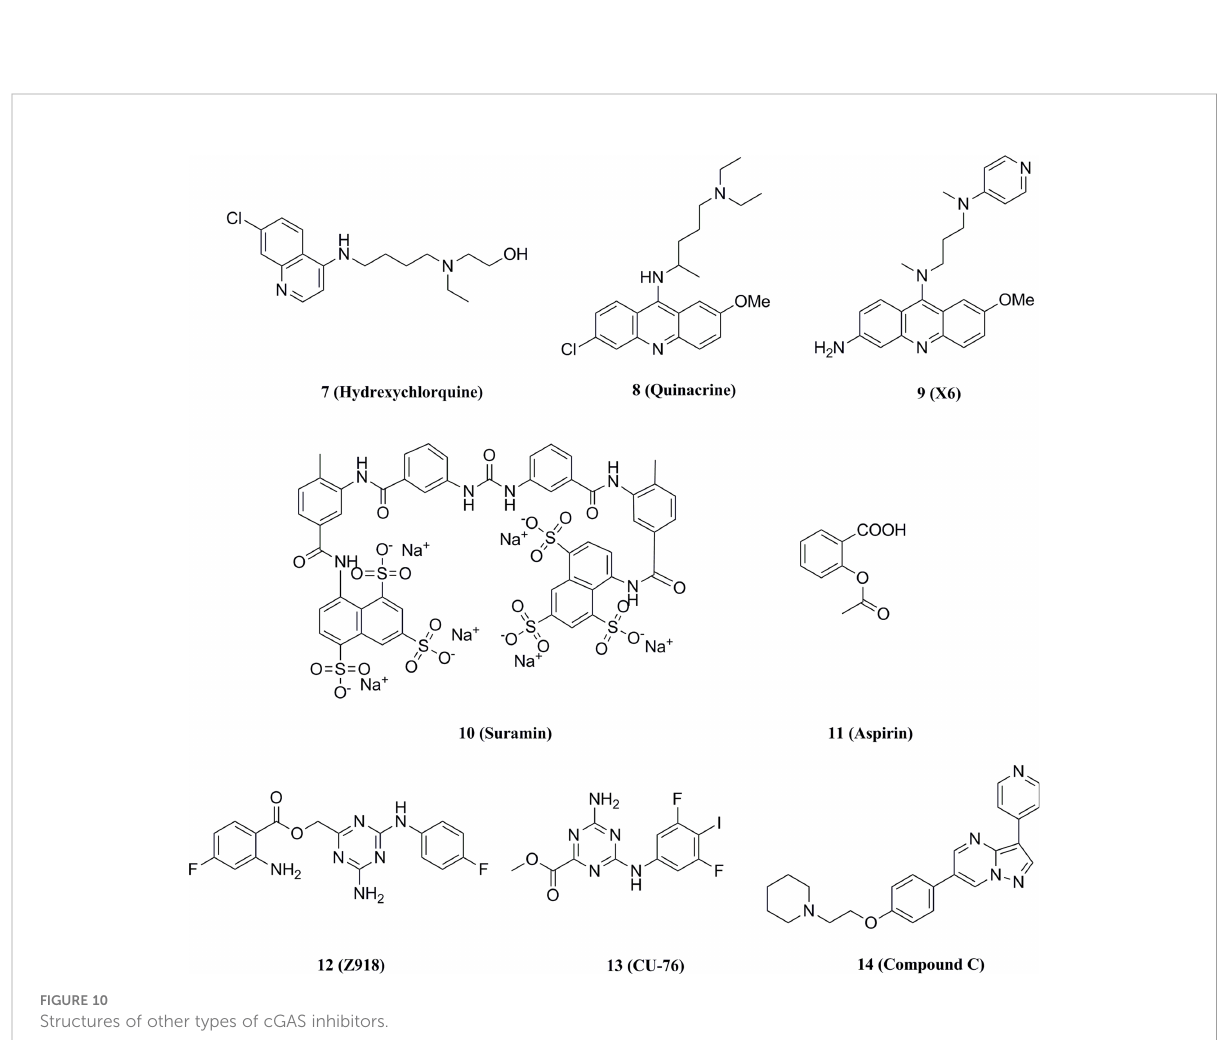
FIGURE 10 Structures of other types of cGAS inhibitors.